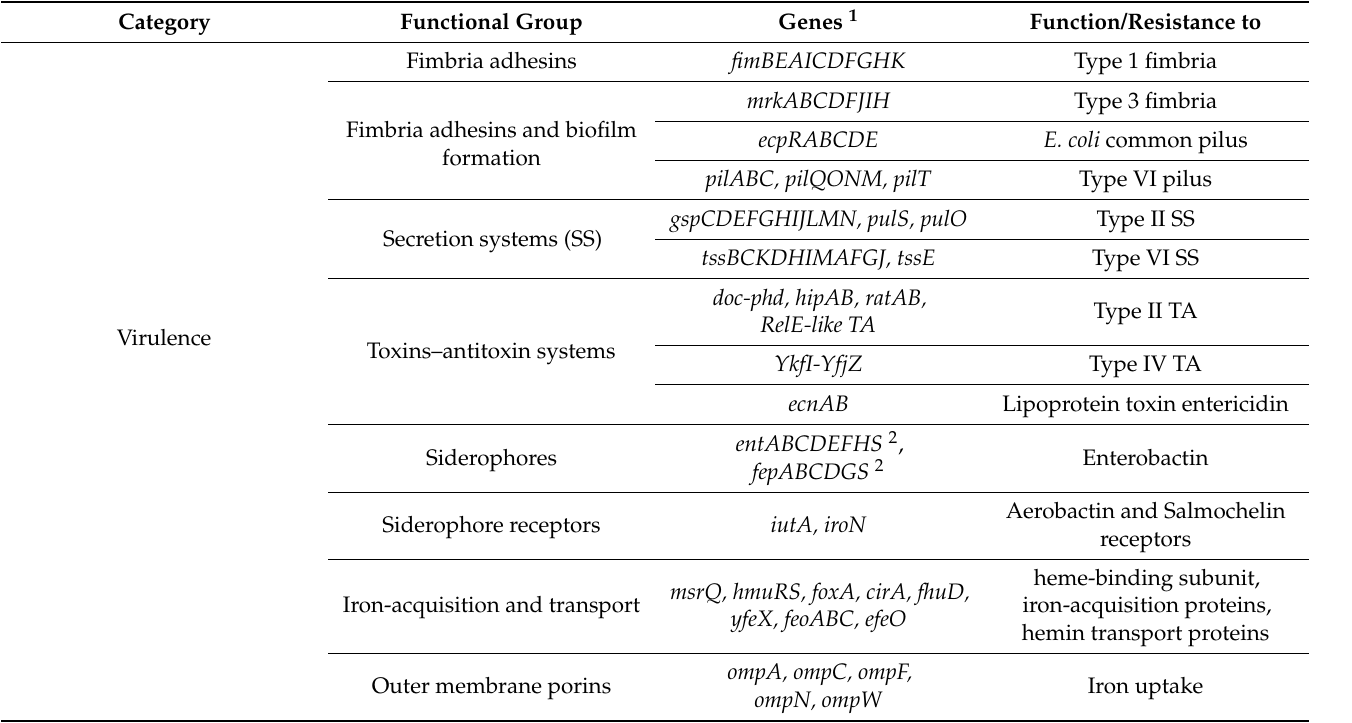
Table 2. KpnU95 chromosomal virulence and antibiotic resistance